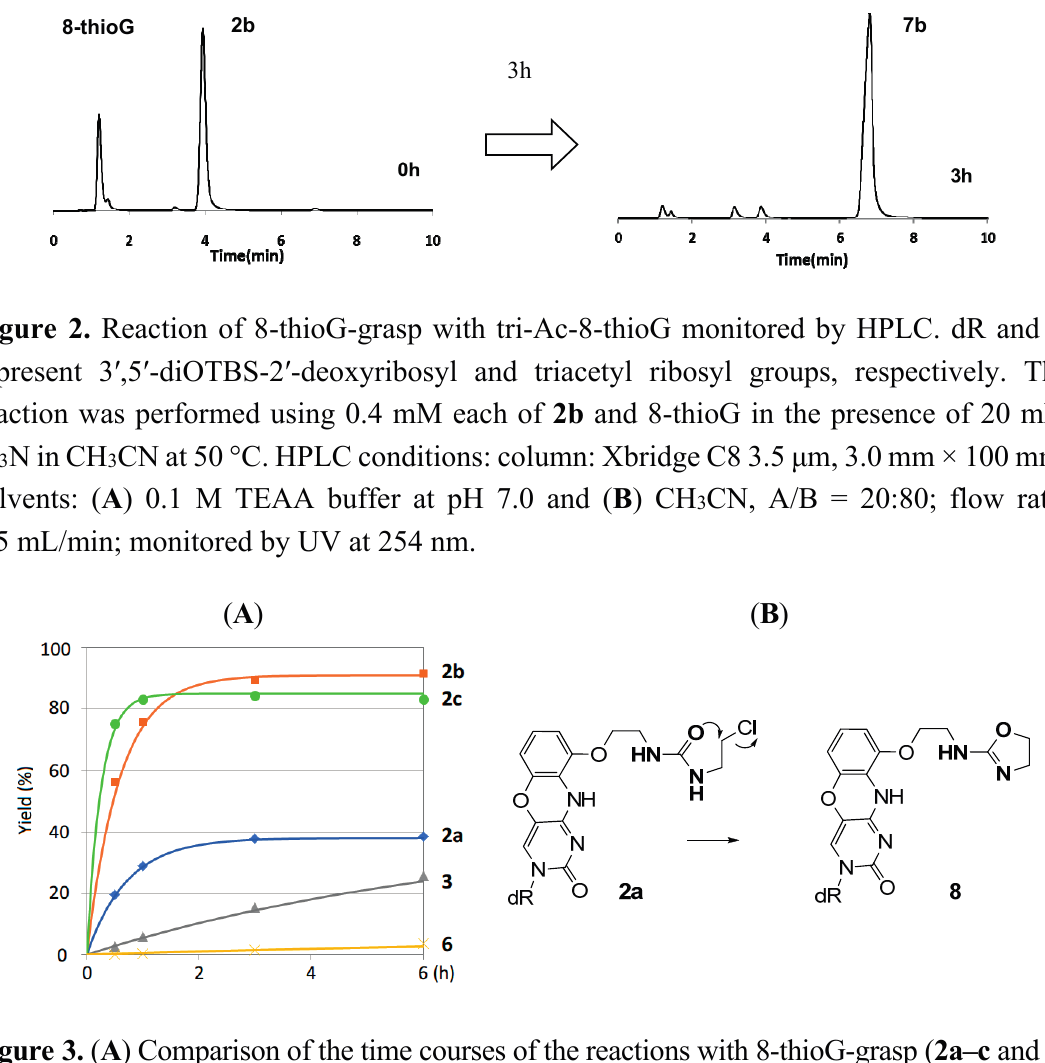
Figure 3. ( A ) Comparison of the time courses of the reactions with 8-thioG-grasp ( 2a–c and 3 ) and the control compound 6 . ( B ) Byproduct 8 formed via the intramolecular reaction of 2a . Product yields were obtained at the indicated time points by HPLC analysis, as described in the footnote to Figure 2. dR represents the 3 ′ ,5 ′ -diOTBS-2 ′ -deoxyribosyl